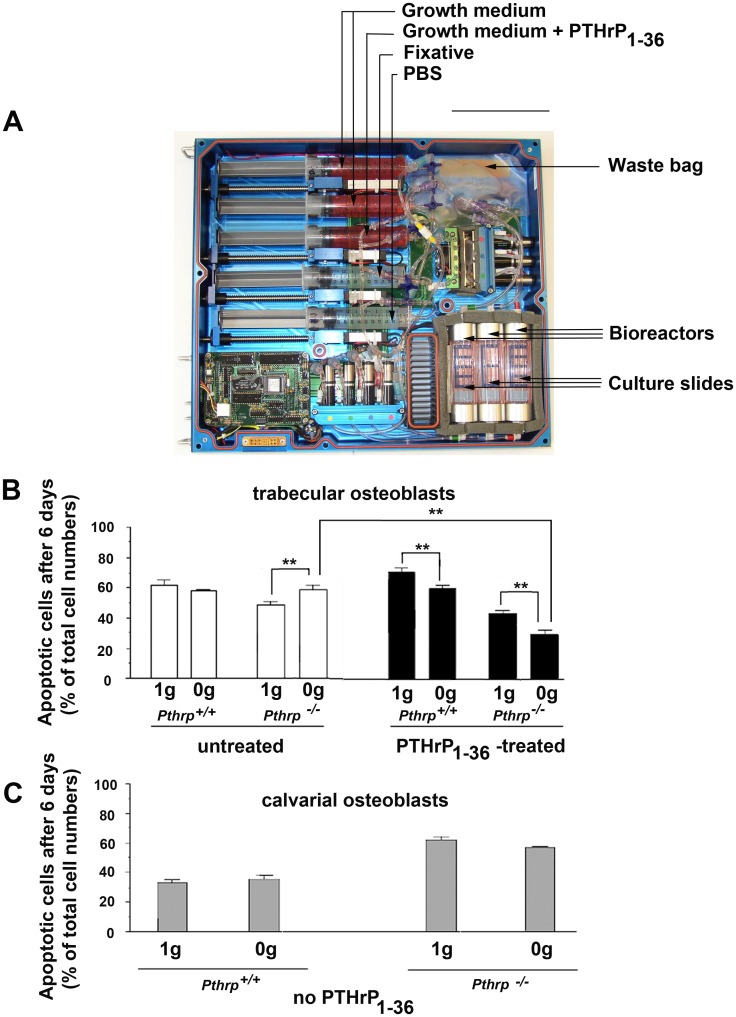
Endogenous PTHrP protects trabecular osteoblasts from Space microgravity-induced apoptosis. (6-day experiments).(A) Automated flight-ready tray for conducting cell culture experiments aboard Foton M3 satellite. Osteoblasts were attached onto CC2 culture slides inside three bioreactors (lower right) in a sealed pathway. (B) Proportion of apoptotic cells in trabecular osteoblasts in bioreactors after 6 days in Space microgravity (0g) or in normal Earth gravity (1g). ** p < 0.01. White bars: untreated; black bars: 2-h daily treatment with PTHrP1-36 10-8M. (C) Proportion of apoptotic cells in calvarial osteoblasts in bioreactors after 6 days in Space microgravity (0g) or in normal Earth gravity (1g). No PTHrP1-36 treatment was conducted on calvarial cells. Scale bar A: 15 cm.